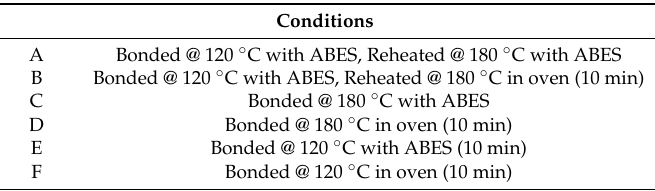
Table 1. Reheating and oven bonding conditions for bonding under different conditions for both the CSPI and LSPI. CSPI: commercially available soy protein isolate; LSPI: lab soy protein isolate; ABES: Automated Bonding Evaluation